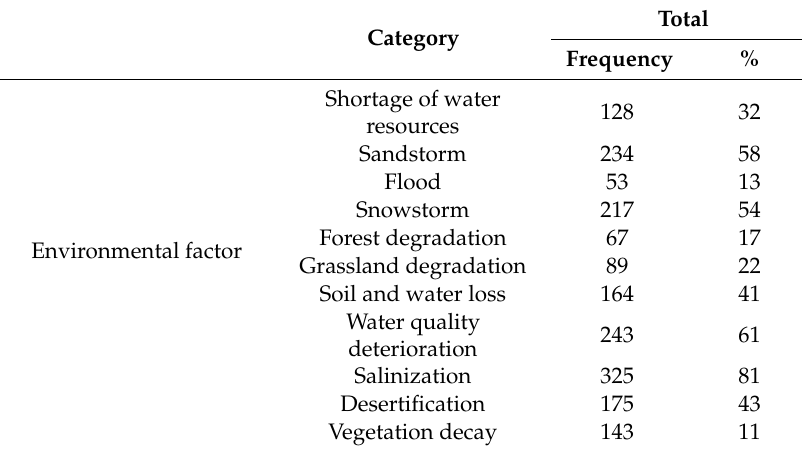
Table 4. Ecological factors affecting farmers’ land use.